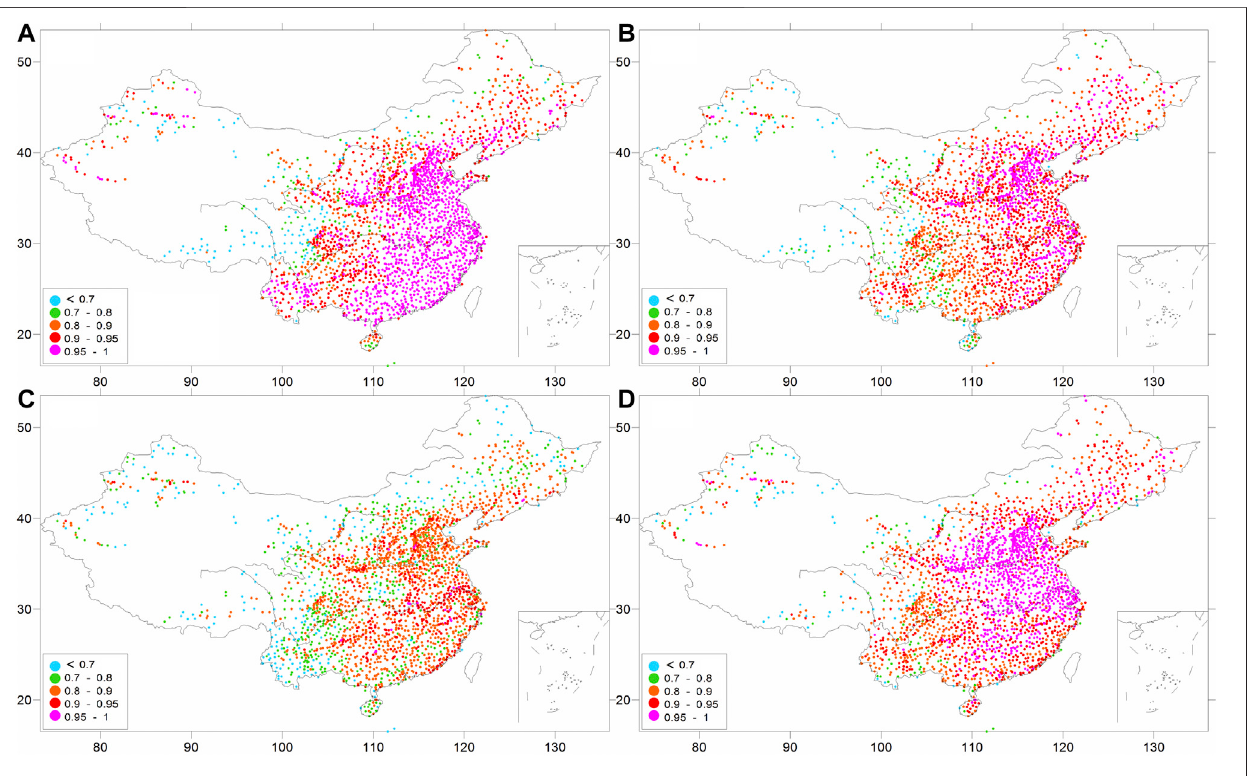
FIGURE5| Spatialdistributionsofcorrelationcoef fi cientsforthecross-validationofprecipitationanomalypercentagein (A) January, (B) April, (C) July,and (D) October.